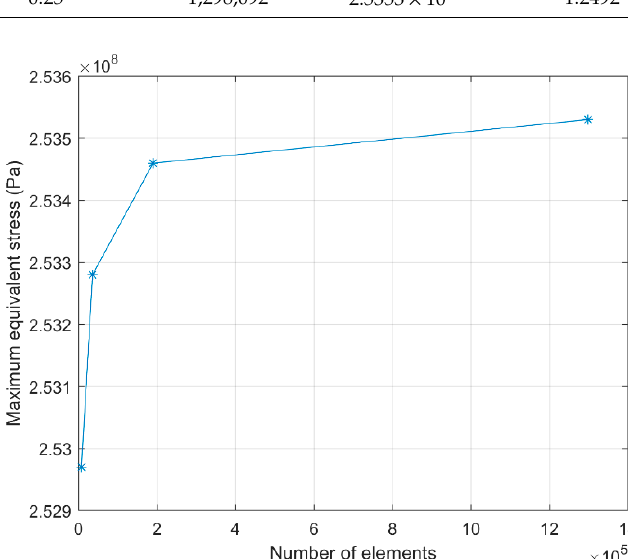
Figure 3. Mesh convergence test.